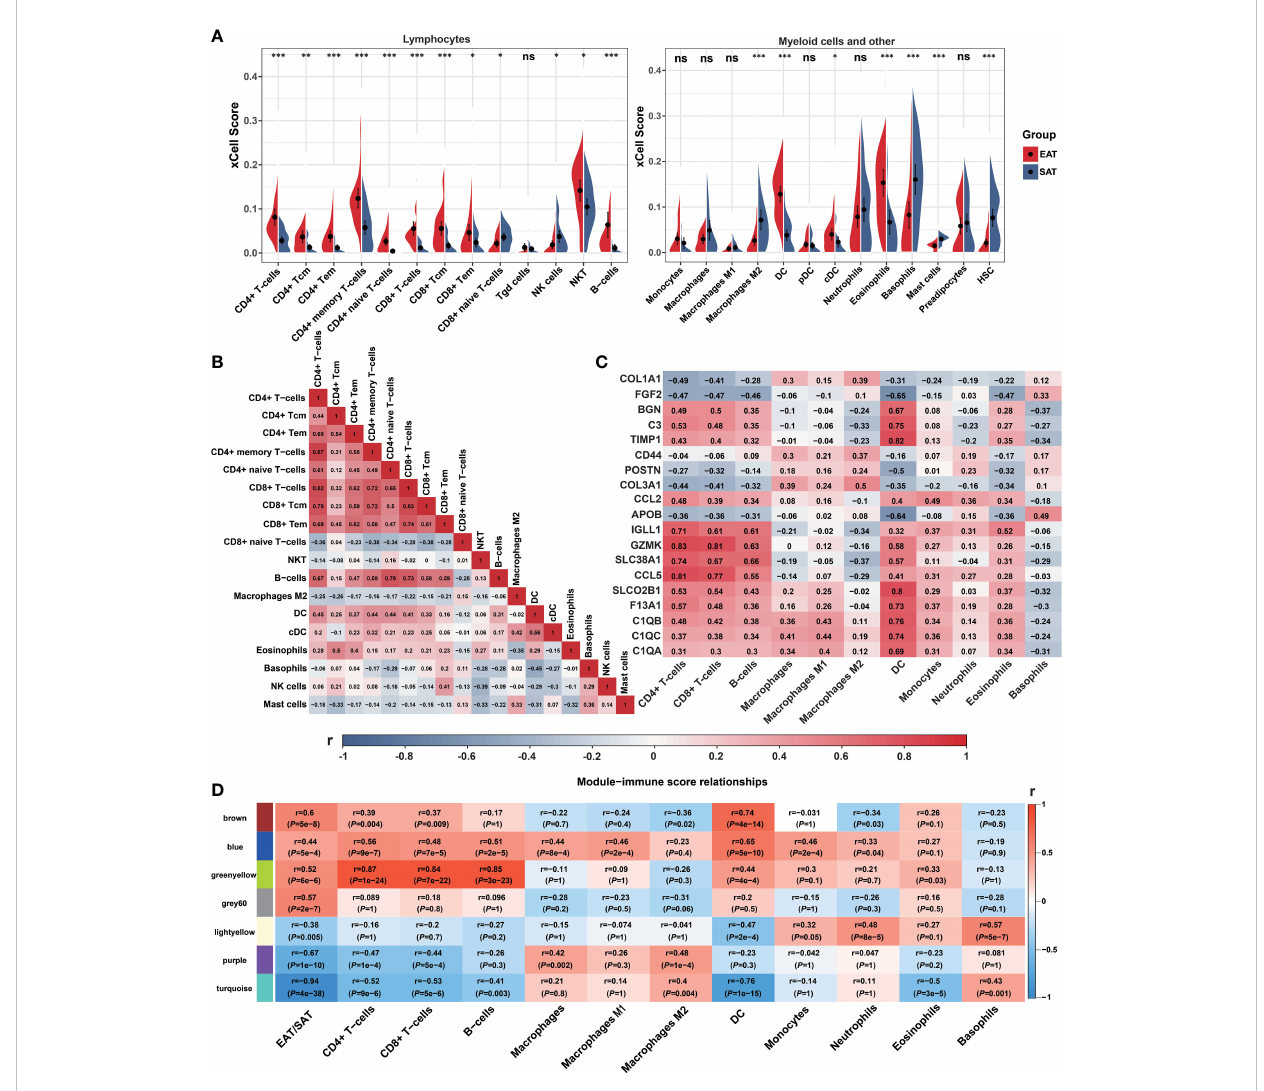
FIGURE 3 Immune cell in fi ltration and correlation analyses. (A) Violin charts of xCell immune in fi ltration score between EAT and SAT. (B) Correlation matrix of immune cell subtypes (Pearson correlation coef fi cients are displayed in the box). (C) Correlation matrix of immune cell in fi ltration scores with 19 identi fi ed key genes (Pearson correlation coef fi cients are displayed in the box). (D) Correlation matrix of immune cell in fi ltration scores with WGCNA key modules. * P < 0.05, ** P < 0.01, *** P < 0.001 and ns refers to no signi fi